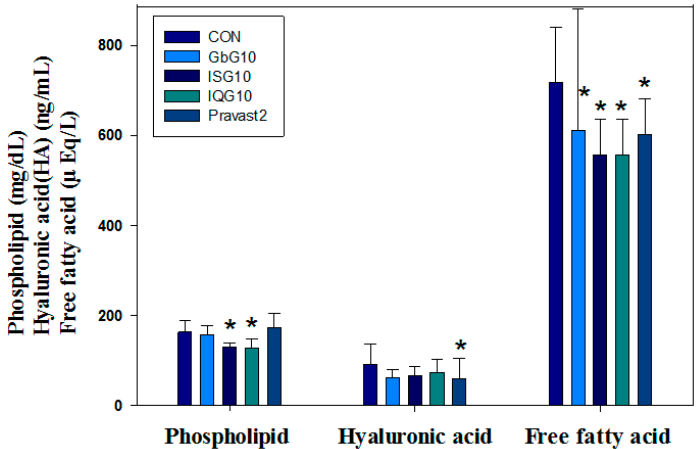
Figure 3. Antilipidemic effect on serum phospholipid, hyaluronic acid, and free fatty acid of insect GAG treated rats on HFD over one month. CON: control. GbG10: G . bimaculatus glycosaminoglycan 10 mg/kg. ISG10: I . sinclairii glycosaminoglycan 10 mg/kg. IQG10: B . ignitus glycosaminoglycan 10 mg/kg. Pravast2: Pravastain 2 mg/kg. (* p < 0.05).